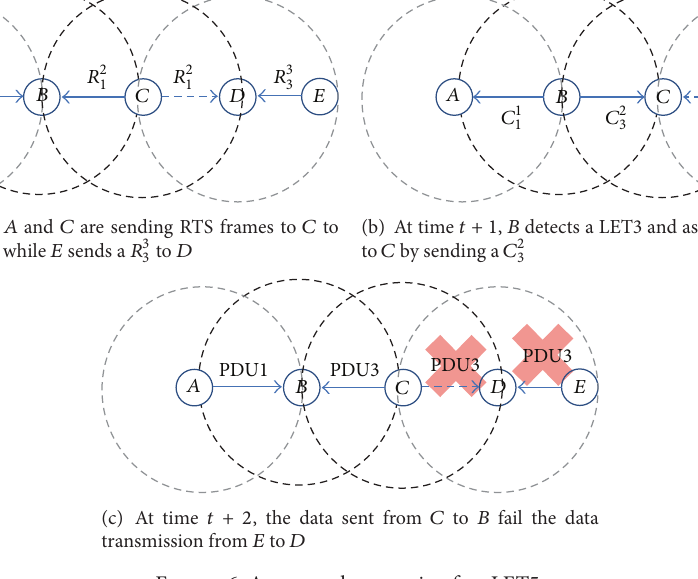
Figure 6: An example scenario of an LET5.